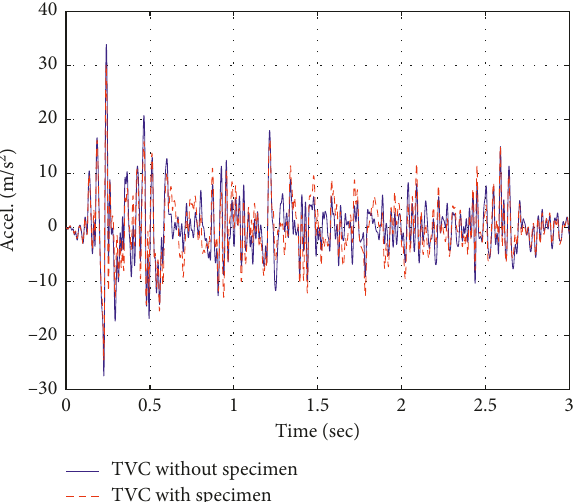
Figure 11: Bode diagram of transfer function H